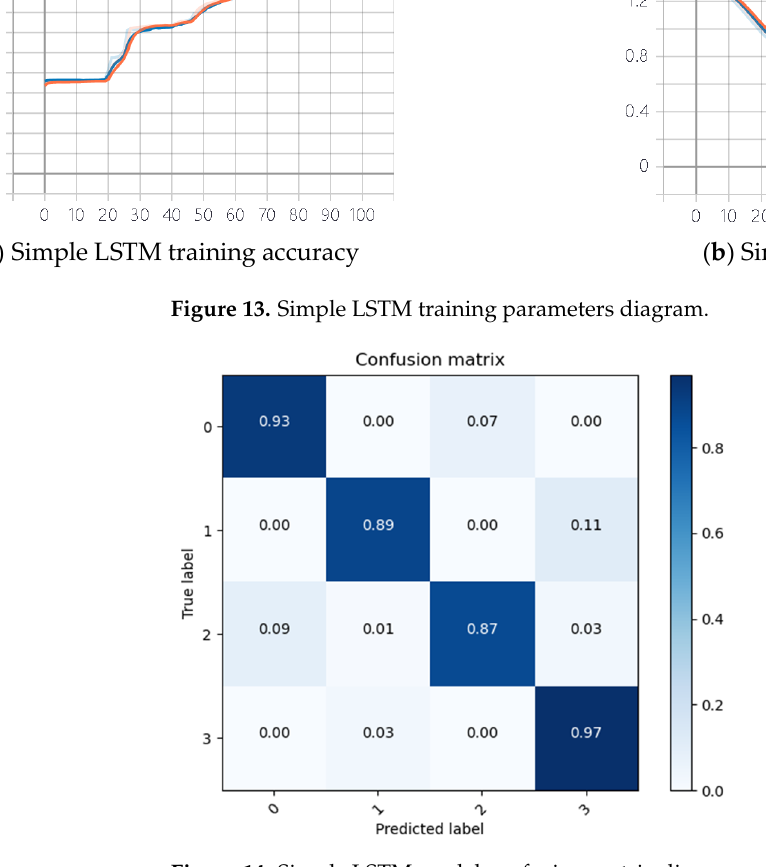
Figure 14. Simple LSTM model confusion matrix diagram.